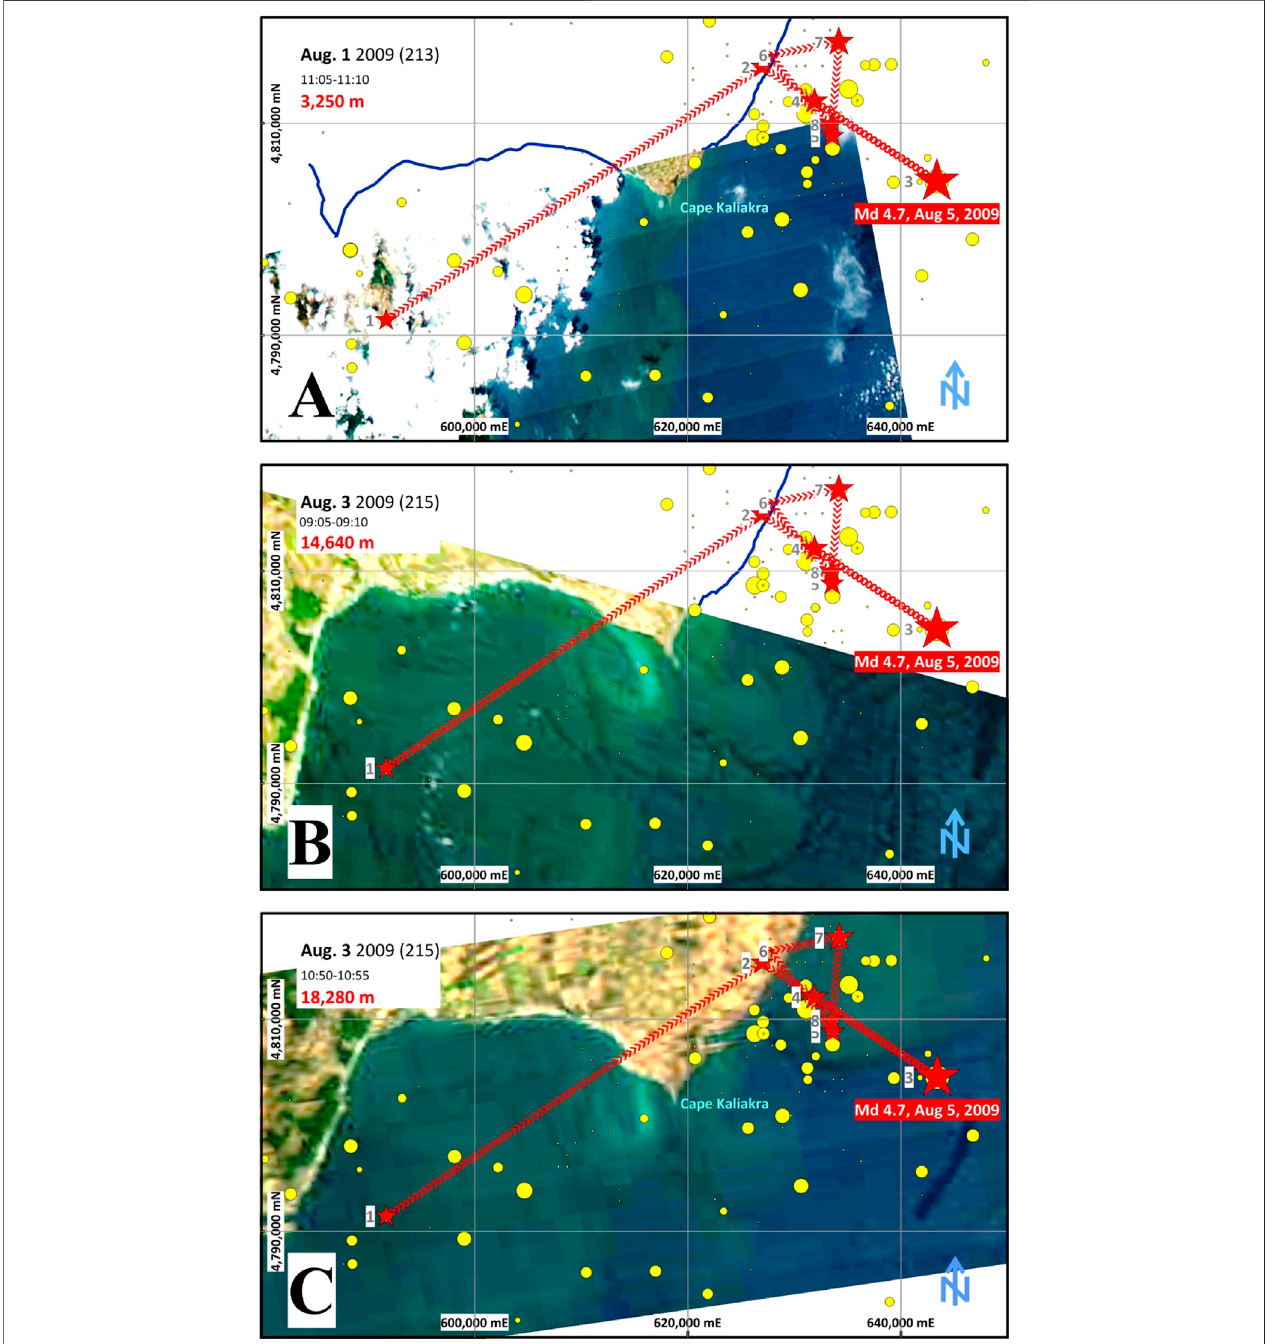
FIGURE 3 | Satellite images from the period 1 to 3 August with superimposed earthquake epicenters. Indicated are the dates of image generation and the lengths of the new possible precursor, the colored jets.